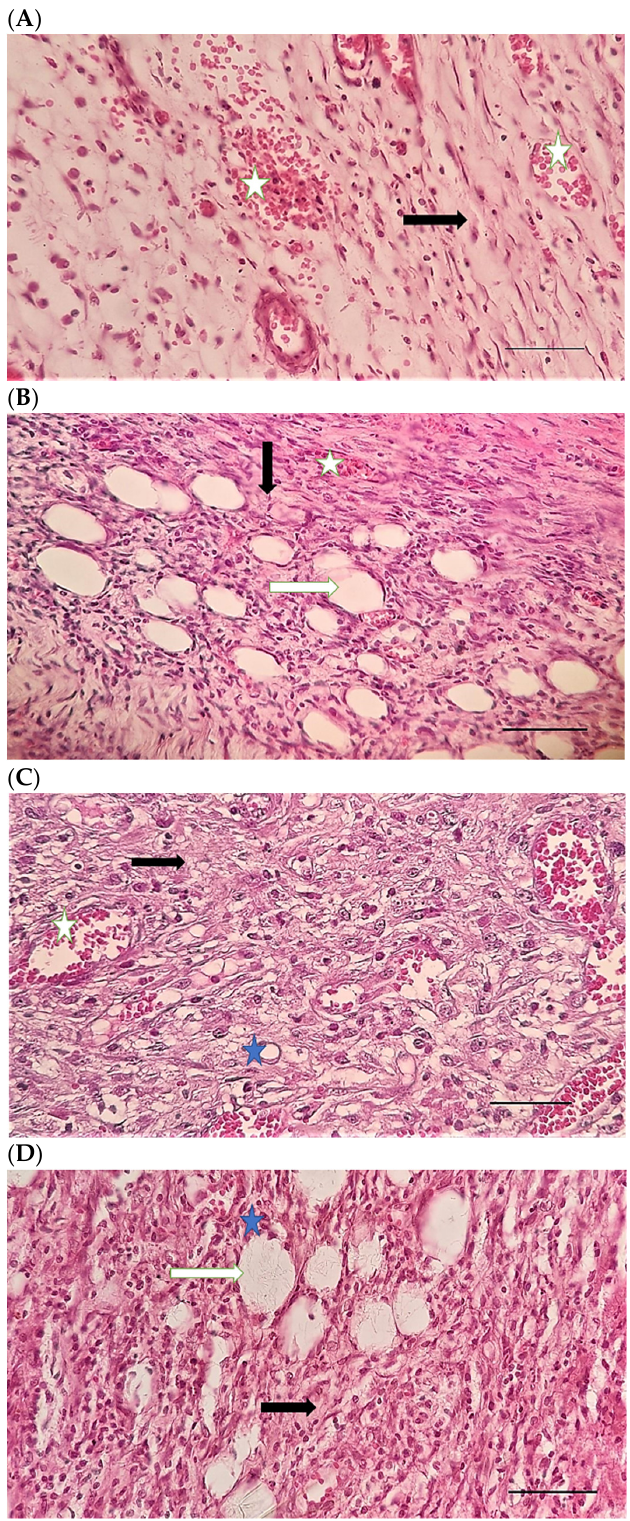
Figure 8. H&E stained microscopic sections (Bar = 100μm) wound in rats on day 7 of the study. ( A ) Control group; Fine collagen fibers (black arrow), hyperemia and hemorrhage (white star). ( B ) Ch group; Edema (white arrow), fine collagen fibers (black arrow), hyperemia (white star). ( C ) ChSeN group; Fine collagen fibers (black arrow), newly formed vessels (blue star), hyperemia (white star). ( D ) ChSeND group; Edema (white arrow), relatively thick collagen fibers (black arrow).